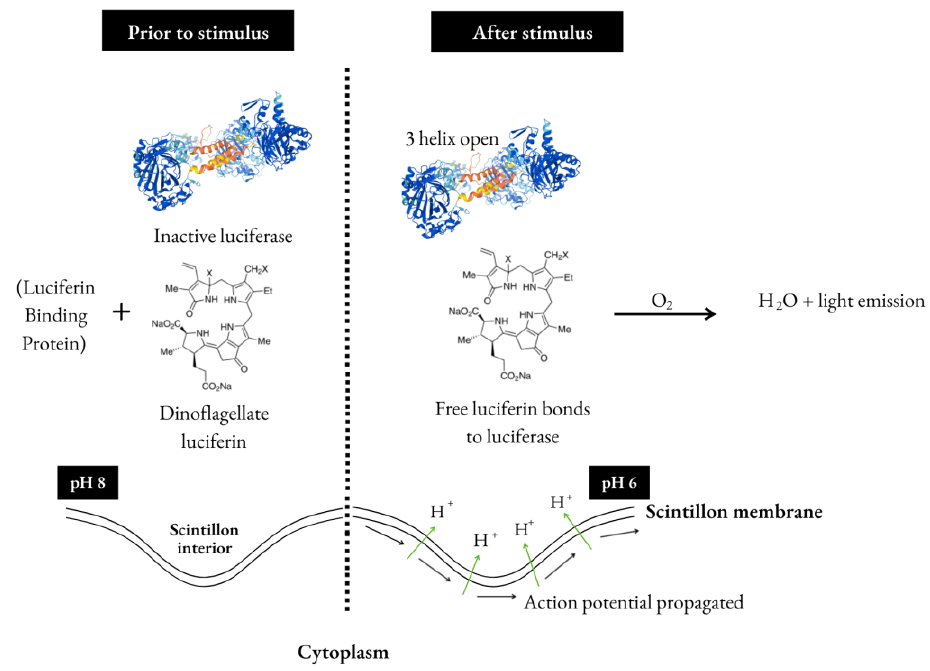
Figure 1. Schematic process for dinoflagellates bioluminescence in the